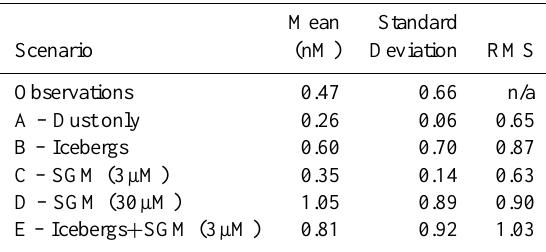
Table 2. Summary statistics (mean, RMS, standard deviation) for observed (Tagliabue et al., 2012) and modelled surface ocean (0– 100m) iron